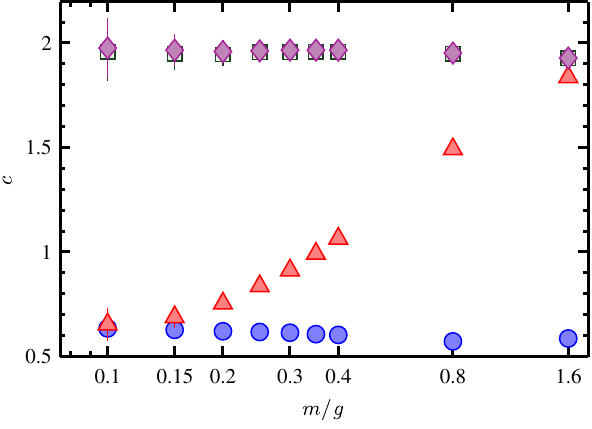
FIG. 9. Central charges extracted from the scaling of the 1 = 2 (blue entanglement entropy as a function of m=g for j max ¼ 1 (red triangles), j 3 = 2 (green squares), and circles), j max ¼ max ¼ 2 (magenta j max ¼